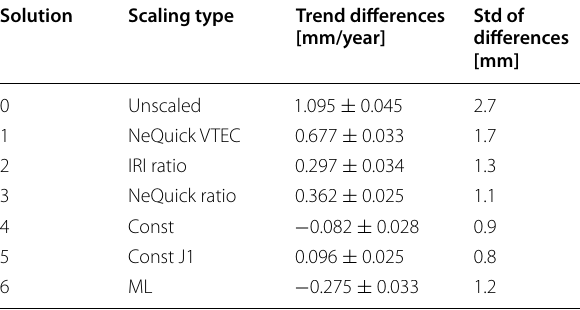
Table 3 Differences in trend with respect to